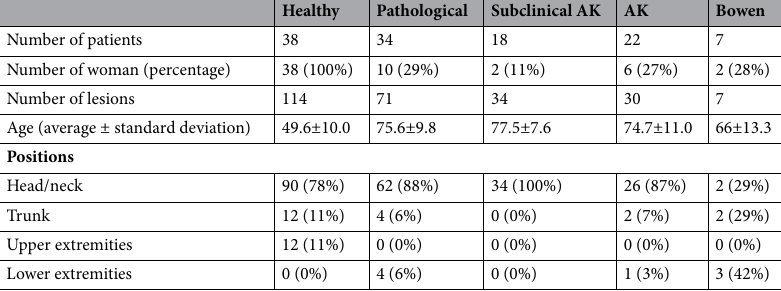
Table 1. Demographics of the healthy and pathological